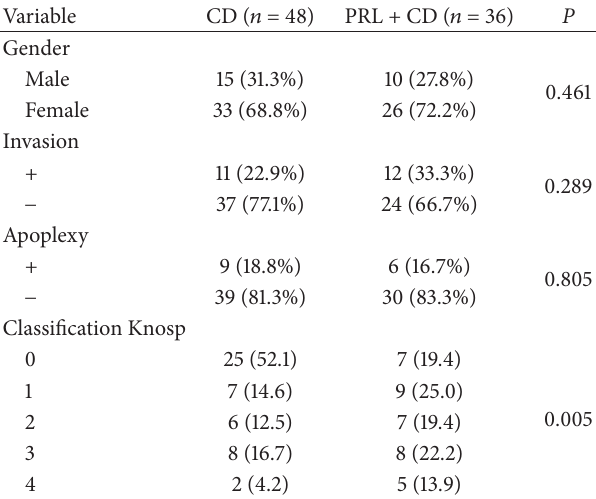
Table 2: Gender, tumor invasiveness, and the presence of pituitary apoplexy in the two groups of